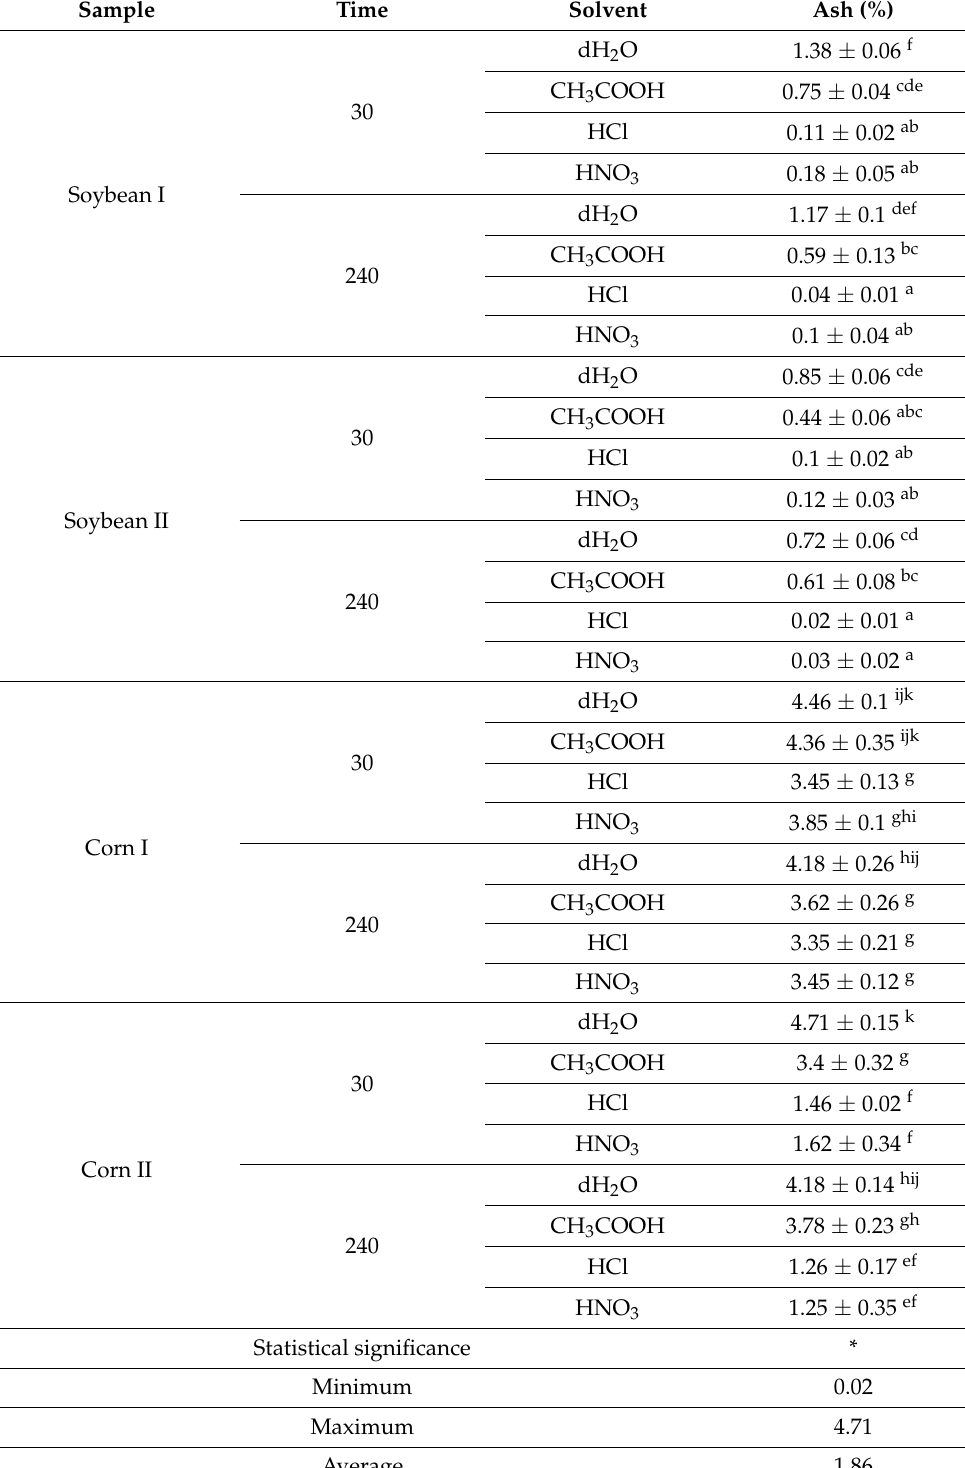
Table 2. Ash content in soybean (I, II) and corn (I, II) after